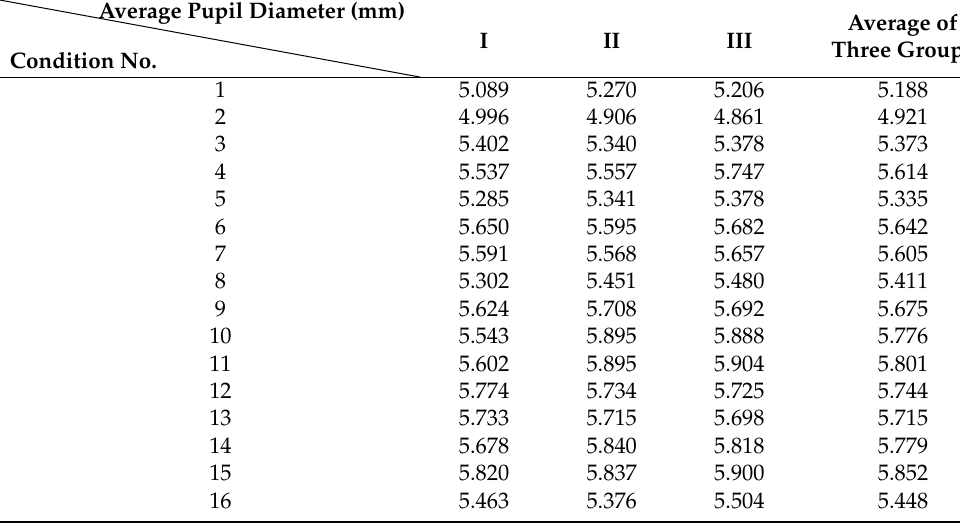
Table 7. Pupil diameter test results under different working conditions.